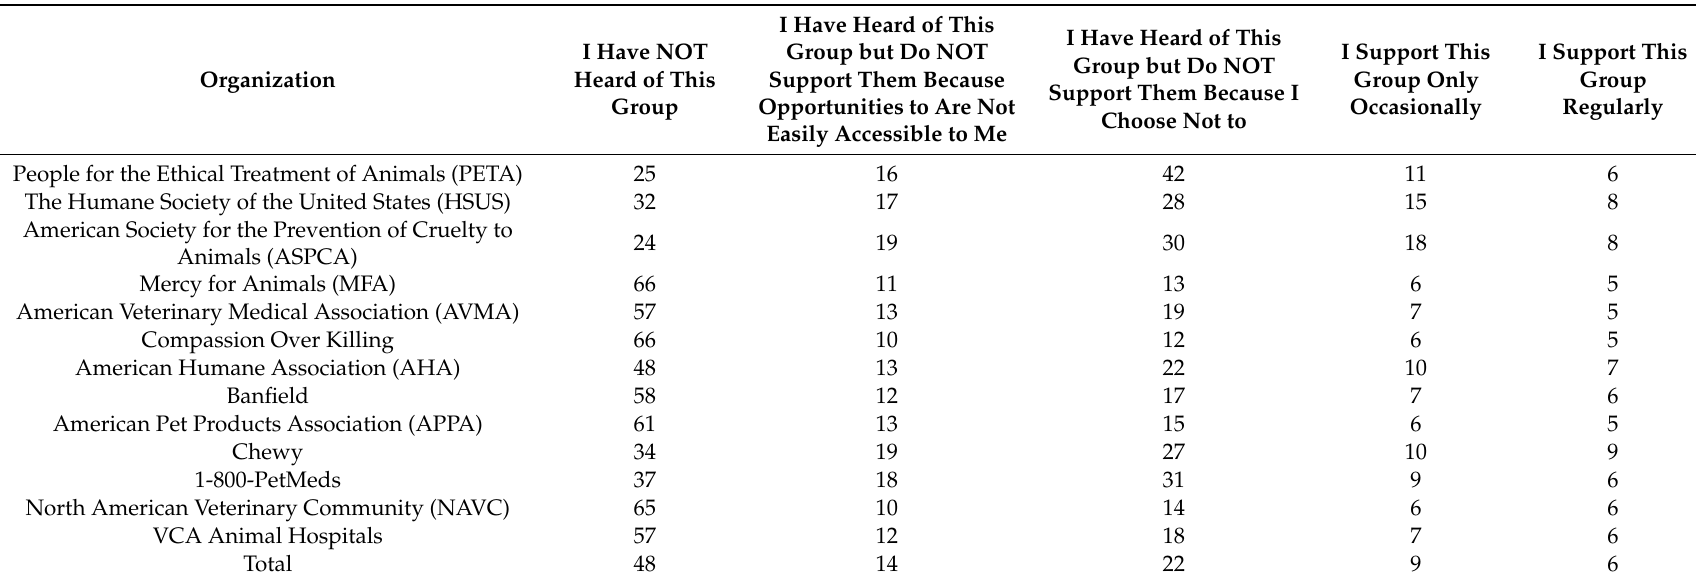
Table 5. Summary of respondent’s knowledge and support of prominent organizations, percent (%) of dog (n = 477) and cat (n = 352)